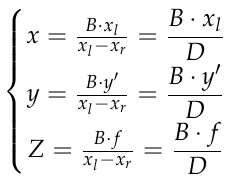
Figure 8. Model for distance measurement by binocular camera.